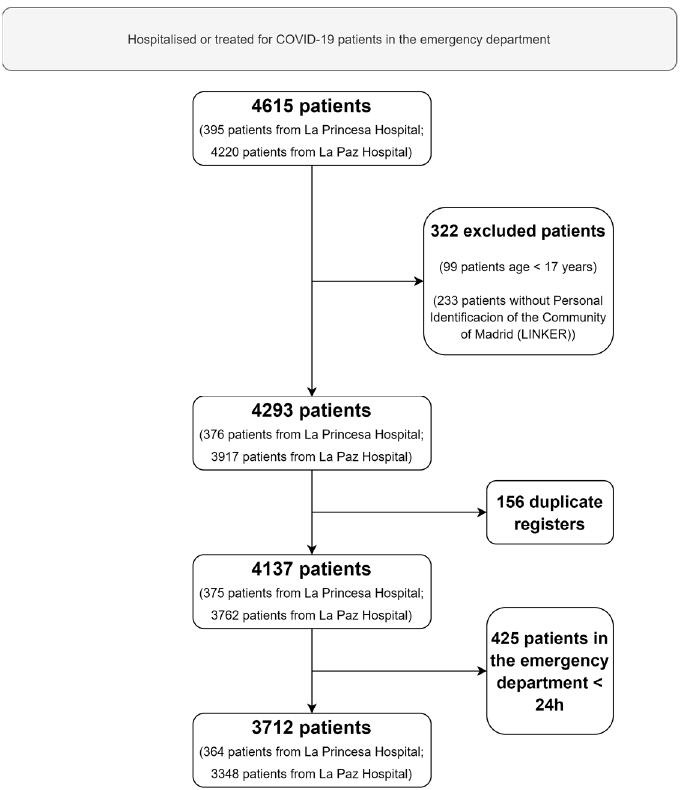
Figure 1. Flow chart of patients included. Table 1. Characteristics on admission and complications during hospitalisation.